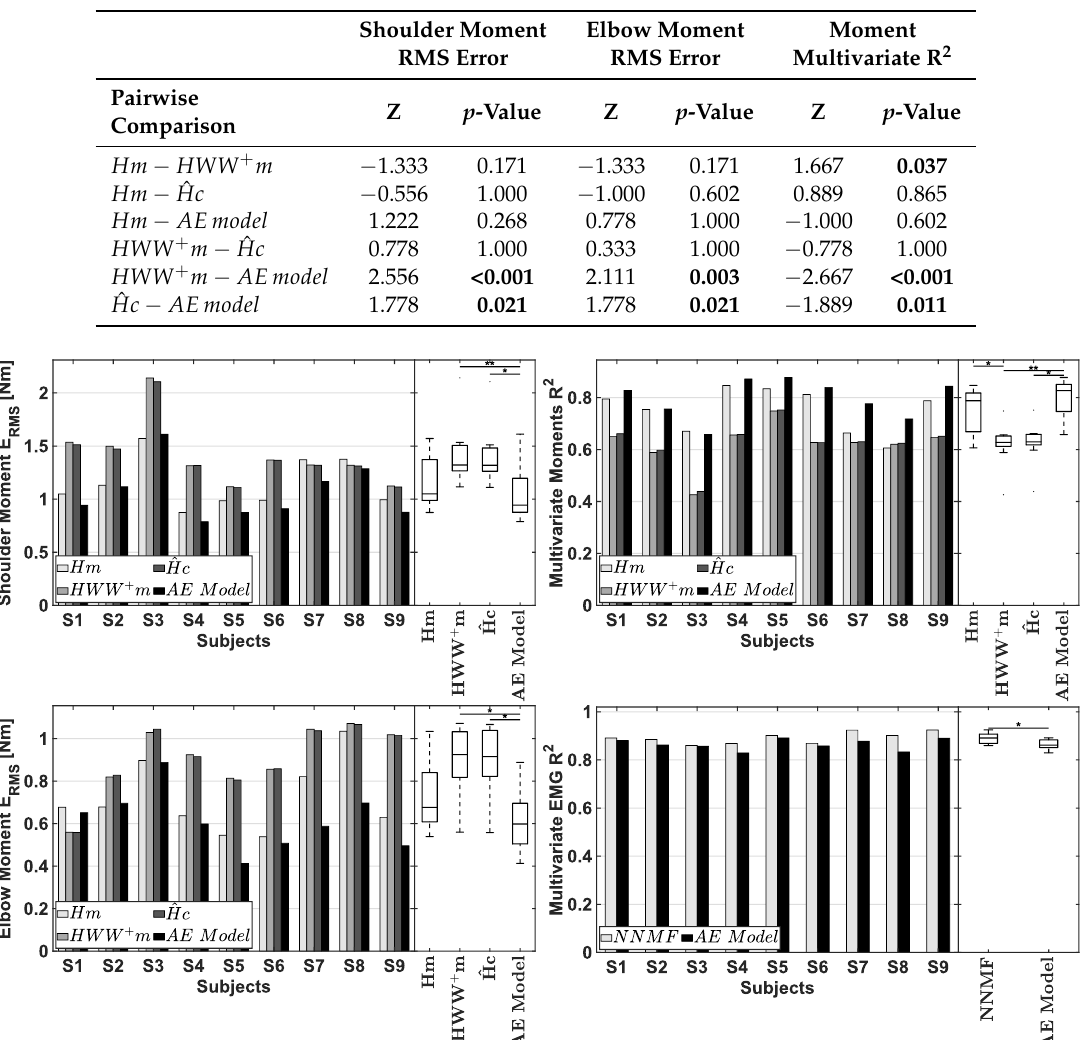
Table 2. Results of the post-hoc analysis about the joint moments. p -values lower than 0.05 are in bold text.